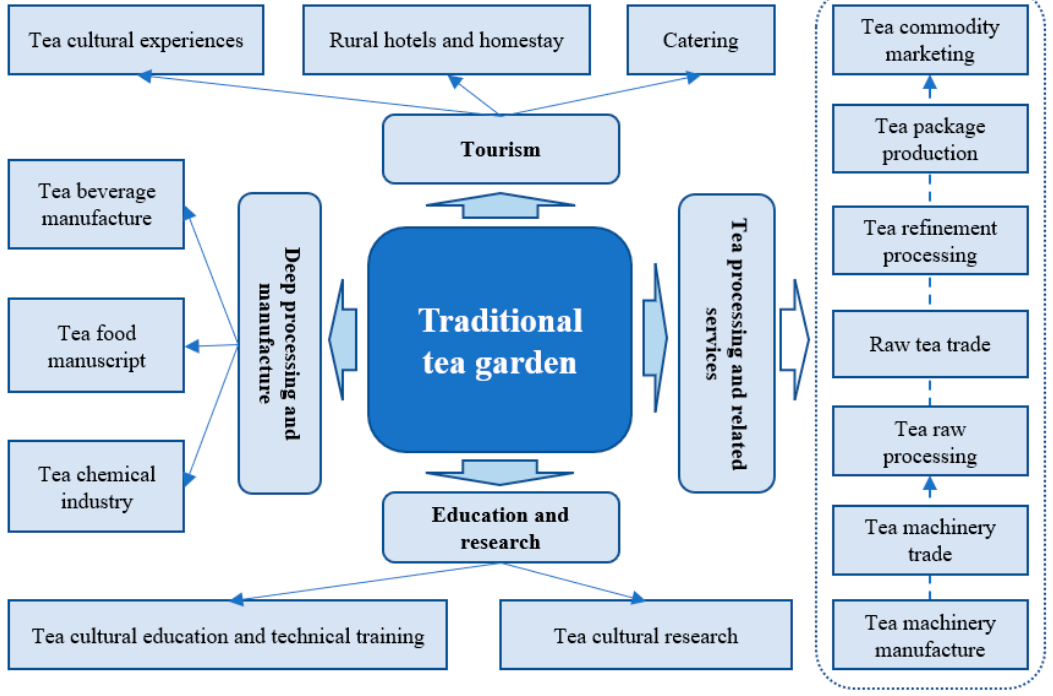
Figure 5. The industrial Chain of Anxi Tieguanyin Tea Culture System.